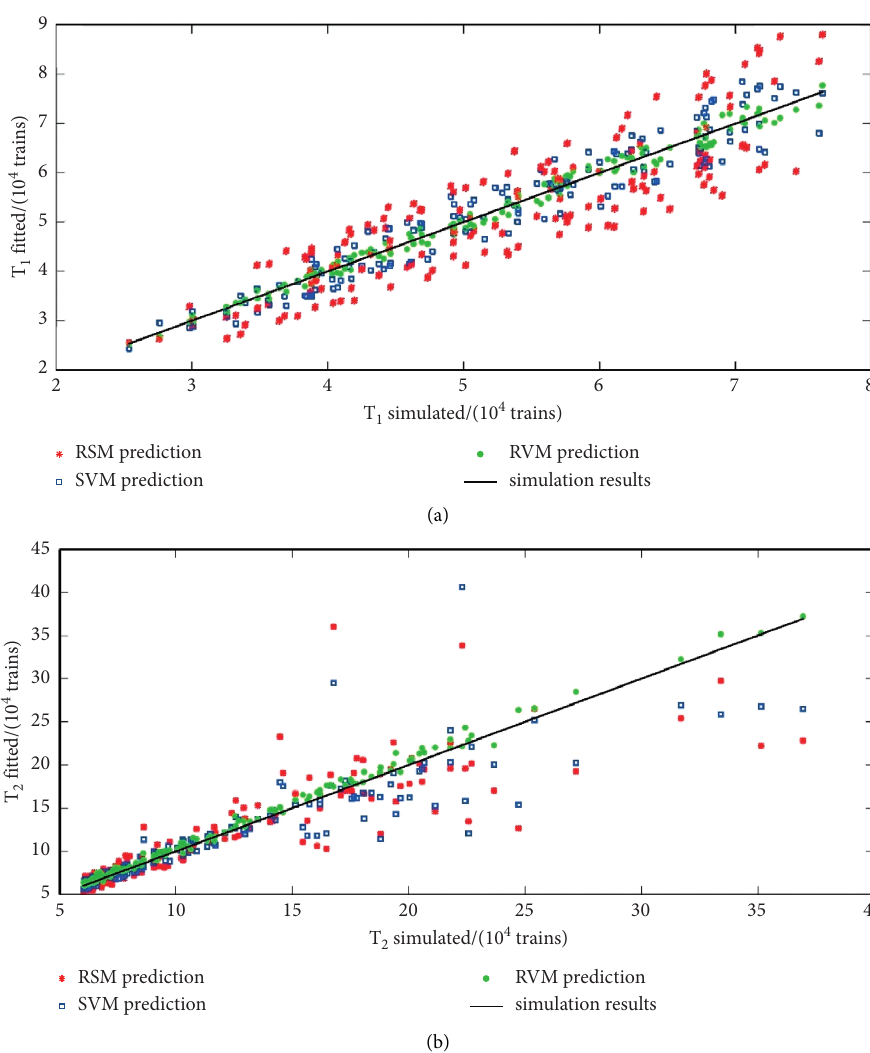
Figure 5: Comparison of predicted and observed values from numerical simulation. (a) Wear regime I. (b) Wear regime